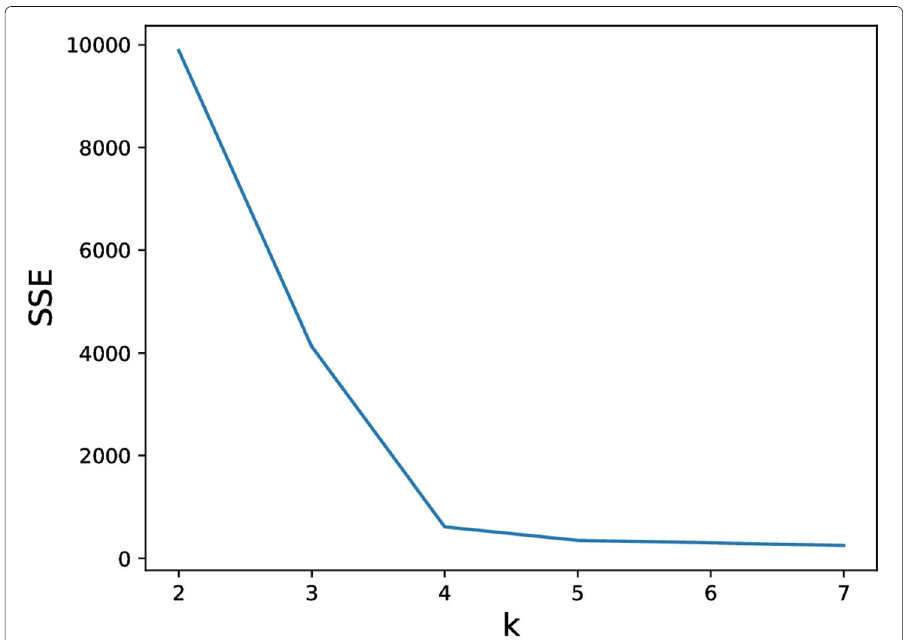
Fig. 4 SSE changes with the value of